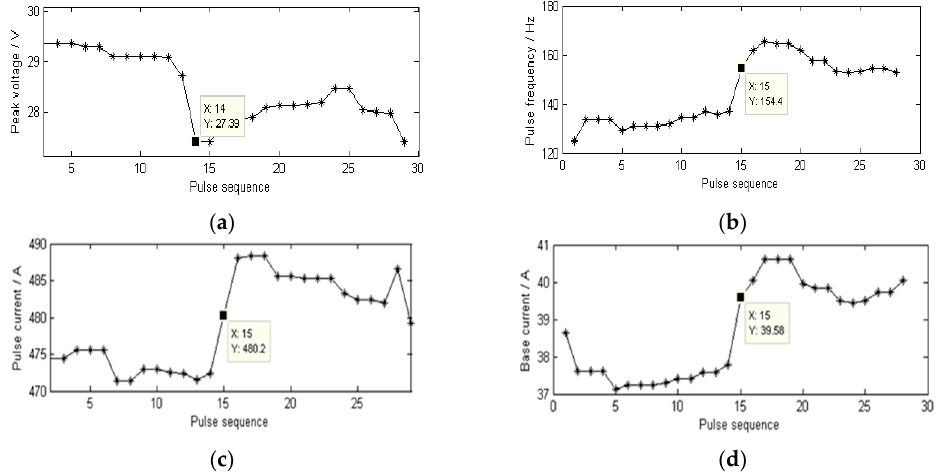
Figure 4. TPS3200 arc length control characteristics: ( a ) Pulse Voltage; ( b ) Pulse frequency; ( c ) Pulse current; ( d ) Base current.